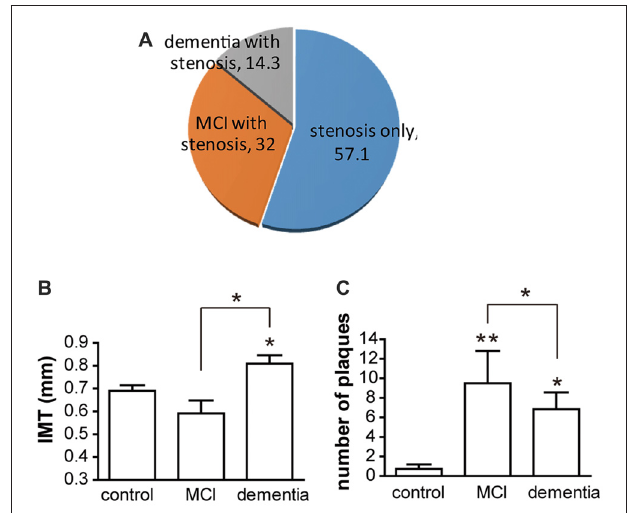
FIGURE 1 | The distribution of participants and atherosclerotic condition. (A) Of participant, patients groups are three. Without cognitive decline, patients with atherosclerosis only are 57.1% of total patients. With atherosclerosis, patients with mild cognitive impairment (MCI) are composed in 32.1% and patients with dementia are constituted in 14.3%. (B) Intima-media thickness (IMT) is shown as mean ± SD. Differences of IMT is significant between dementia and control group. Also it is significant between dementia and MCI. (C) Numbers of plaques are shown as mean ± SD. There are significant differences between control and MCI; control and dementia; and MCI and dementia. ∗ p < 0.05 vs. control group, ∗∗ p < 0.01 vs. control